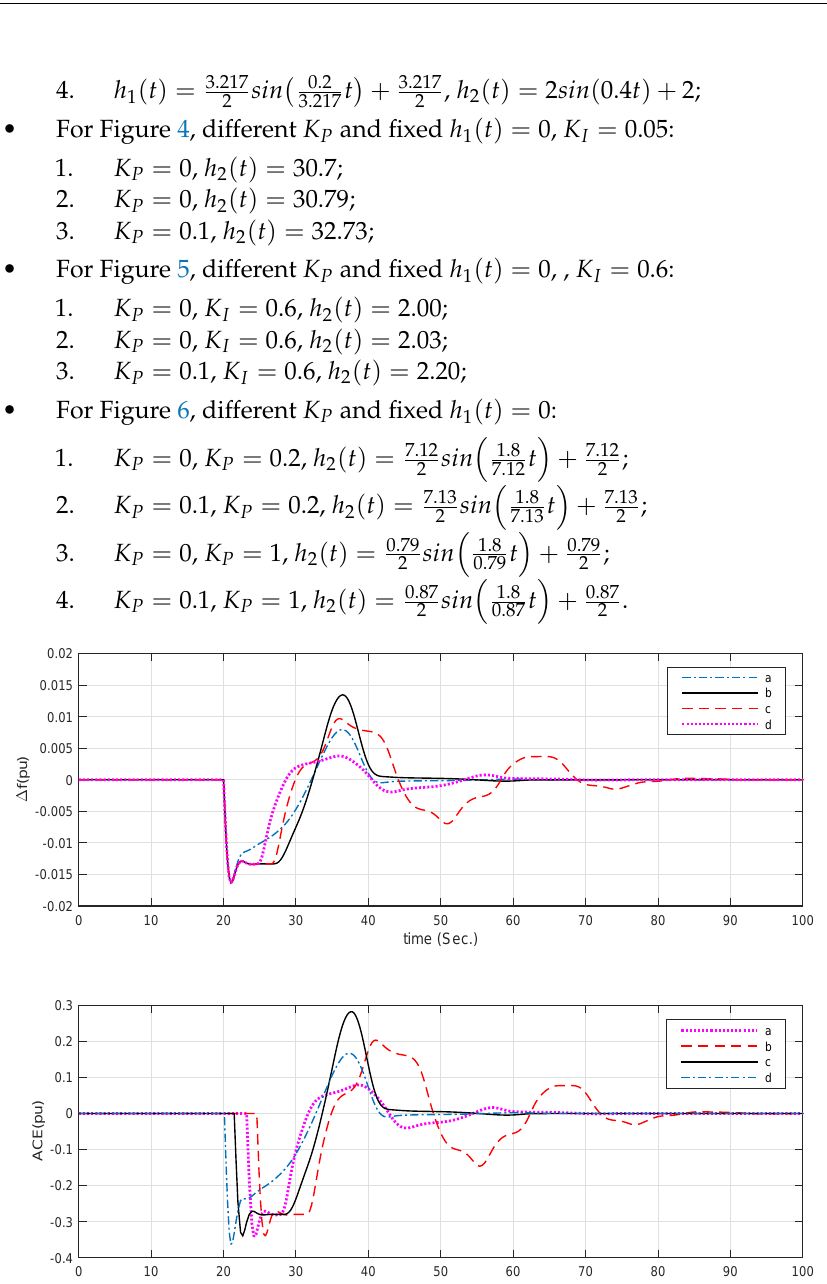
Figure 3. Frequency deviation and control error responses of one-area deregulated LFC scheme with K P = 0.2, K I = 0.1 and different time-varying